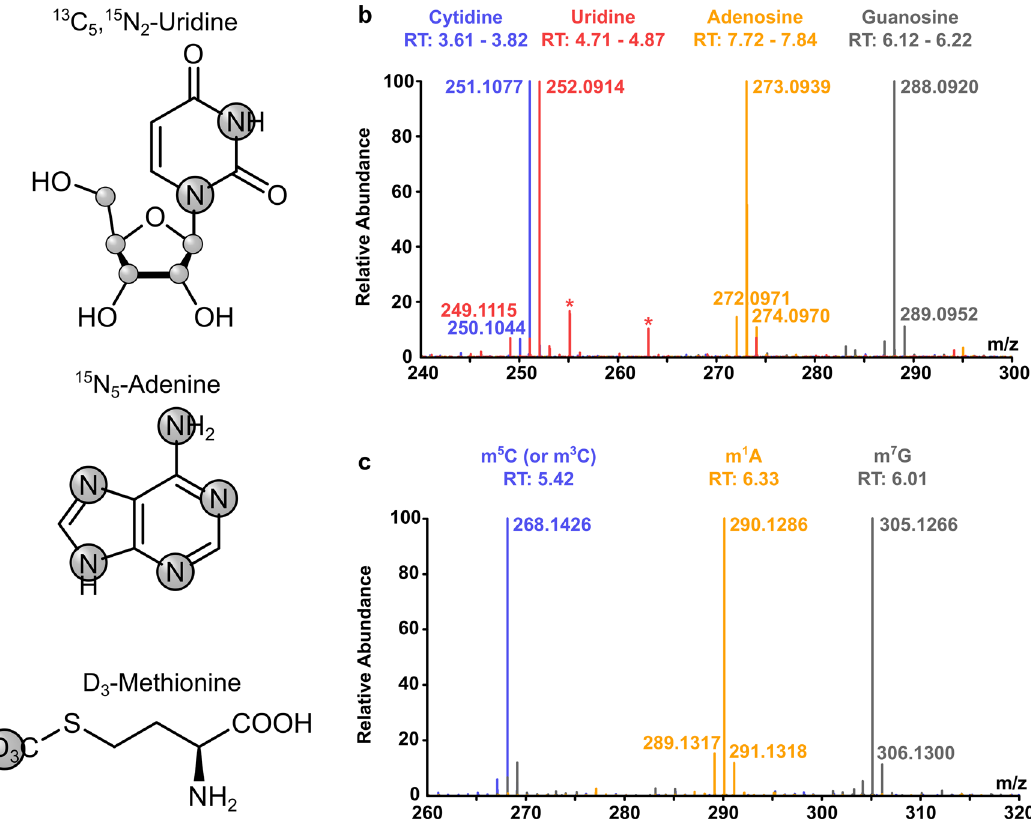
Fig. 2 High resolution mass spectra of stable isotope labeled nucleosides from cell culture. a Labeling of compounds used for stable isotope labeling in cell culture. Grey circles indicate the positions of isotopes ( 13 C, 15 N, or 2 H/D). b Merged high resolution mass spectra of the 4 canonical nucleosides of total tRNA after labeling of HEK 293 cells with shown compounds for 7 days. Background signals are marked with asterisks. c Merged high resolution mass spectra of three exemplary modi fi cations (m 5 C, m 7 G, and m 1 A) in total tRNA after stable isotope labeling of HEK 293 cells for 7